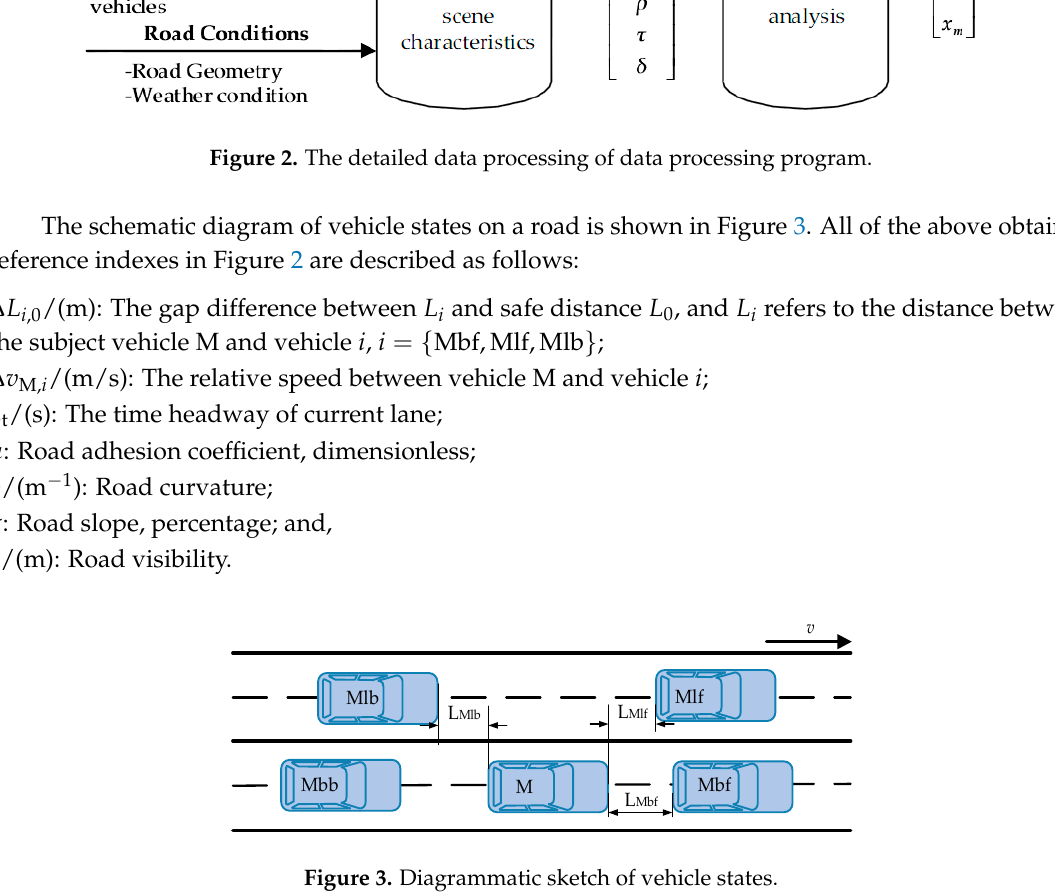
Figure 3. Diagrammatic sketch of vehicle states.